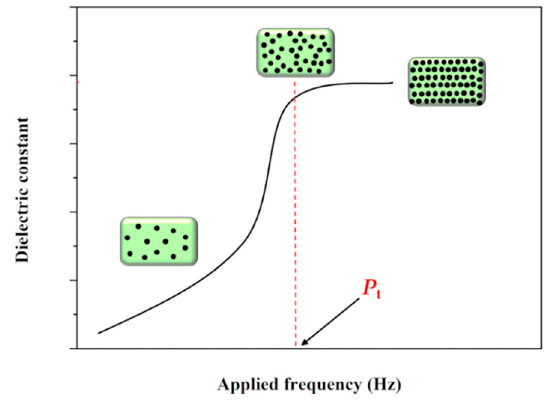
Figure 5. Sketch representing the percolation theory model, where P t = percolation threshold.